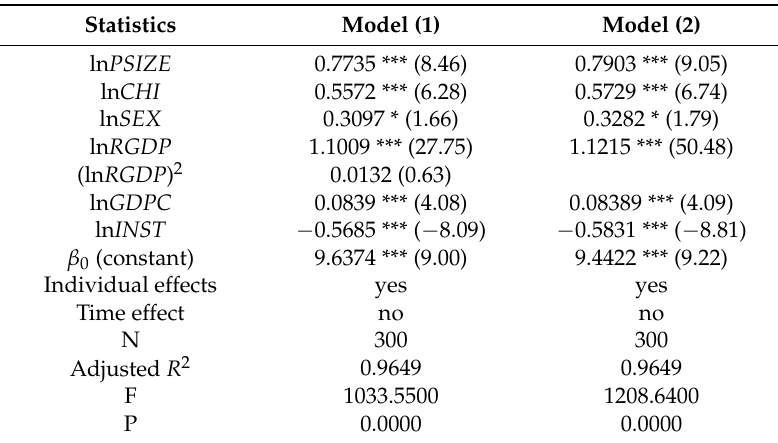
Table 7. Estimated results of fixed effect